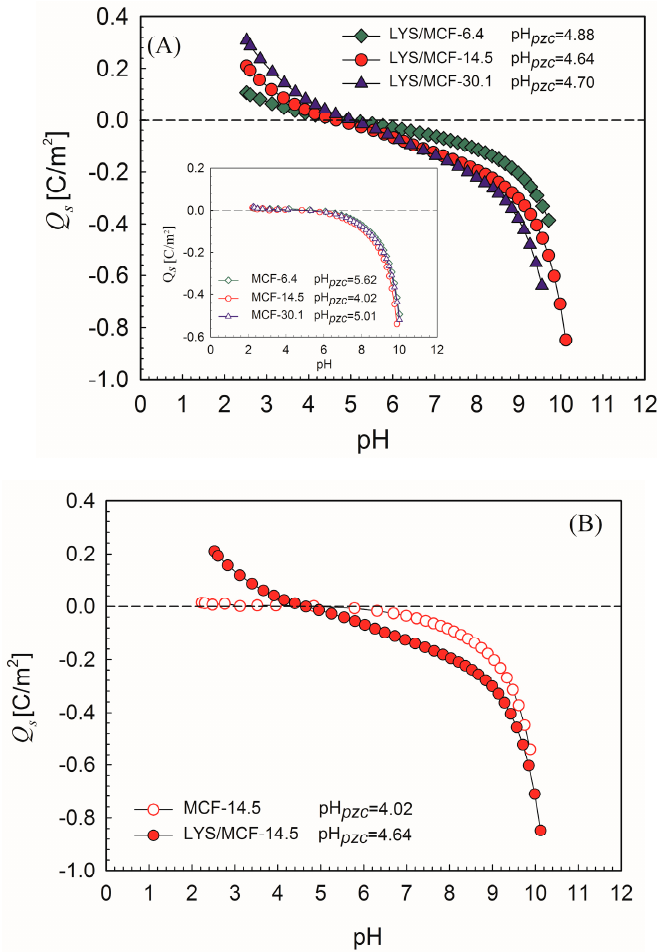
Figure 3. ( A ) Dependence of surface charge density, Q s , on pH for MCF-6.4, MCF-14.5, MCF-30.1 materials with immobilized lysozyme. Inset: dependence of Q s vs. pH for pure MCF-6.4, MCF-14.5, MCF-30.1 silicas; ( B ) Surface charge density, Q s , for MCF-14.5 before and after LYS adsorption. The measurements were carried out by potentiometric titration for ionic strength I = 0.1 mol/L.